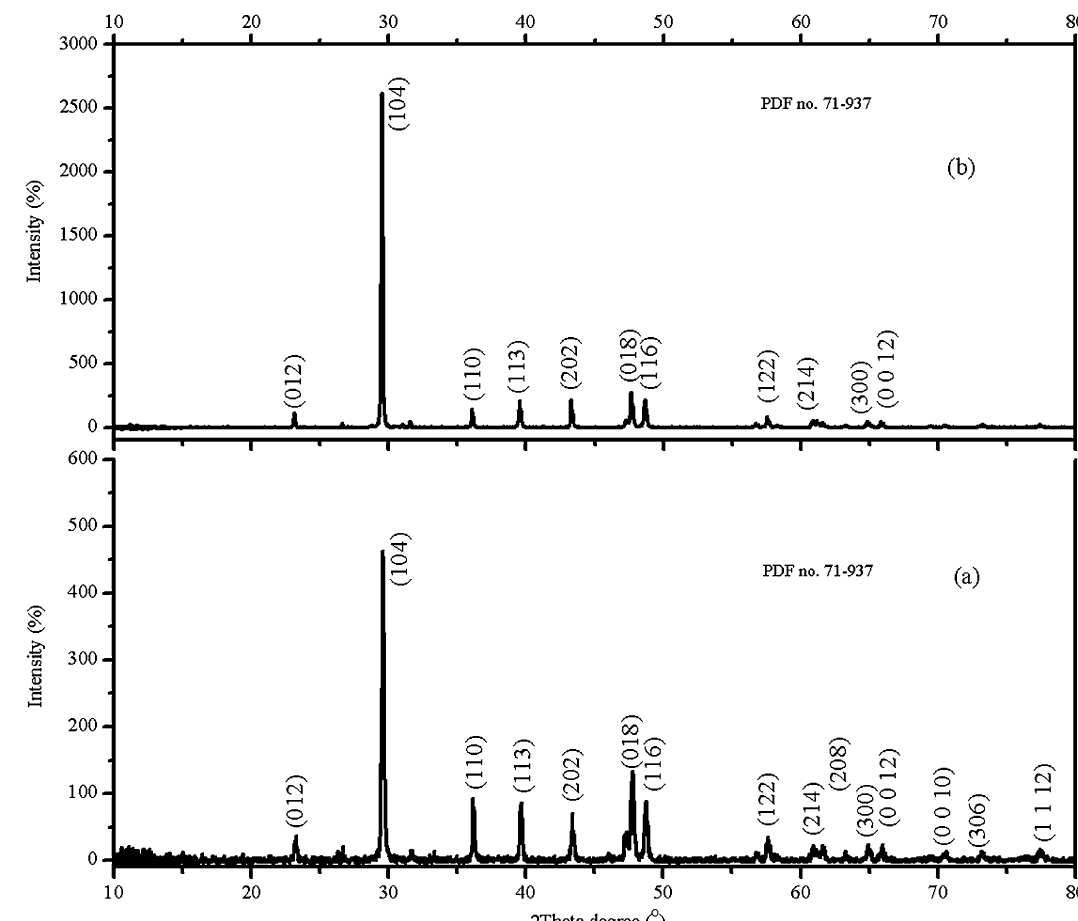
Figure 2. X-ray diffraction patterns of low-purity (a) and high-purity (b) calcium carbonates obtained from powdered eggshell